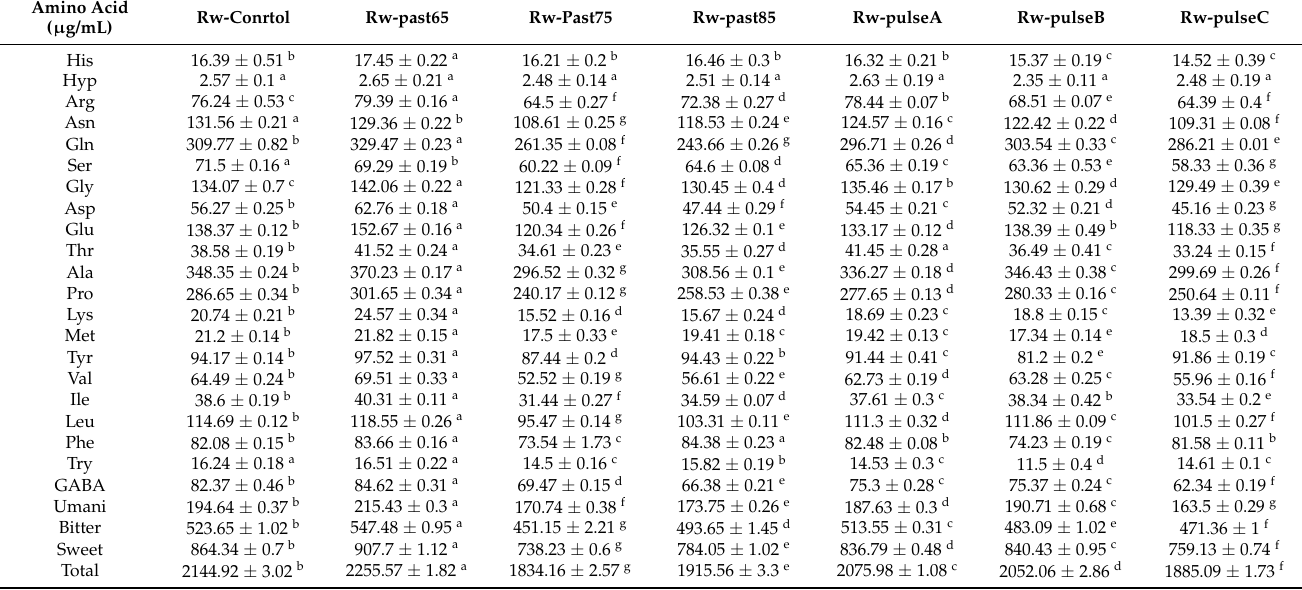
Table 3. Effects of different sterilization conditions on free amino acids in